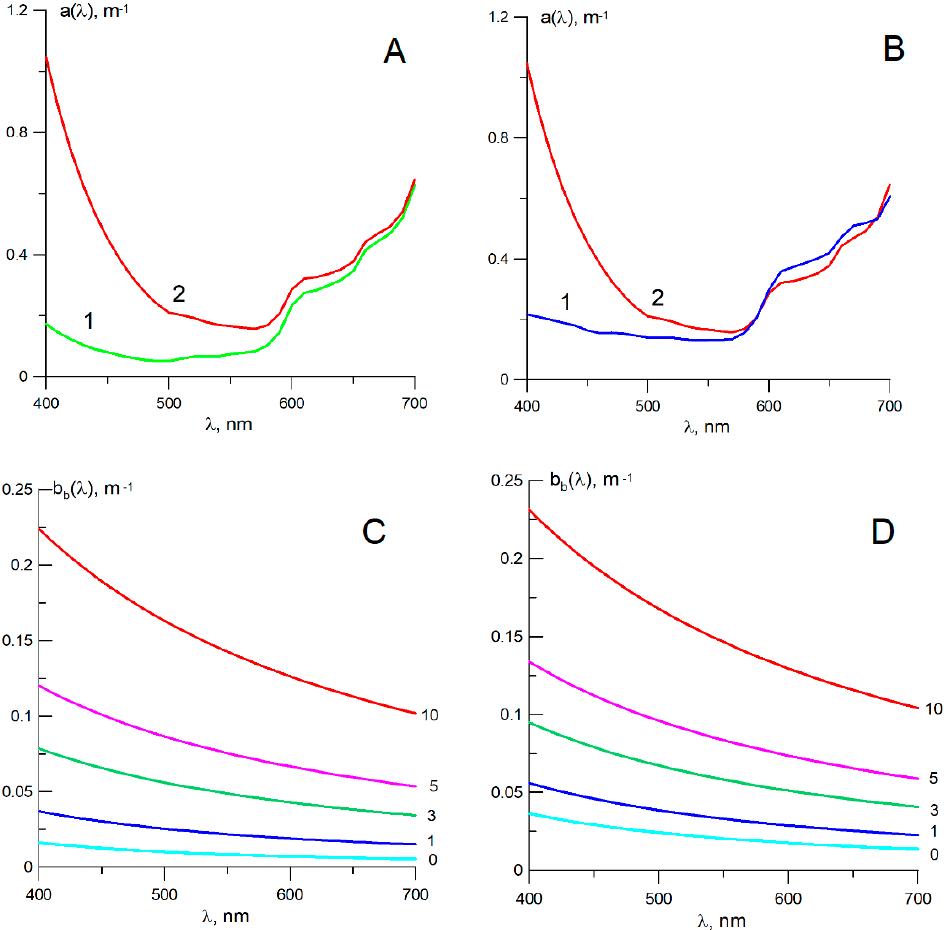
Figure 3. Spectral values of the absorption coefficient ( A , B ) and the backscattering coefficient depending on the N coc (10 6 cell/L) concentration ( C , D ): A, C, the Black Sea; B, D, the Barents Sea. The curves 1